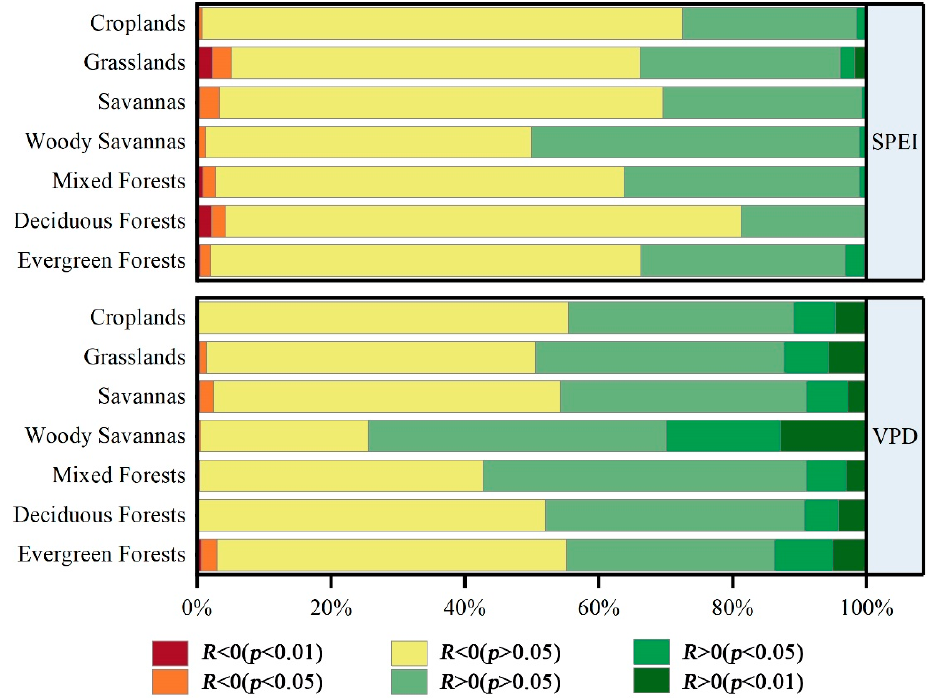
Figure 10. Frequency distribution of the areas with correlation coefficients ( R ) between GPP drought_month (the average GPP of all drought months in a year) and SPEI drought_month (the sum of the absolute values of SPEI for all drought months in a year; upper panel)/VPD drought_month (the sum of the values of VPD for all drought months in a year; lower panel) for different vegetation types.